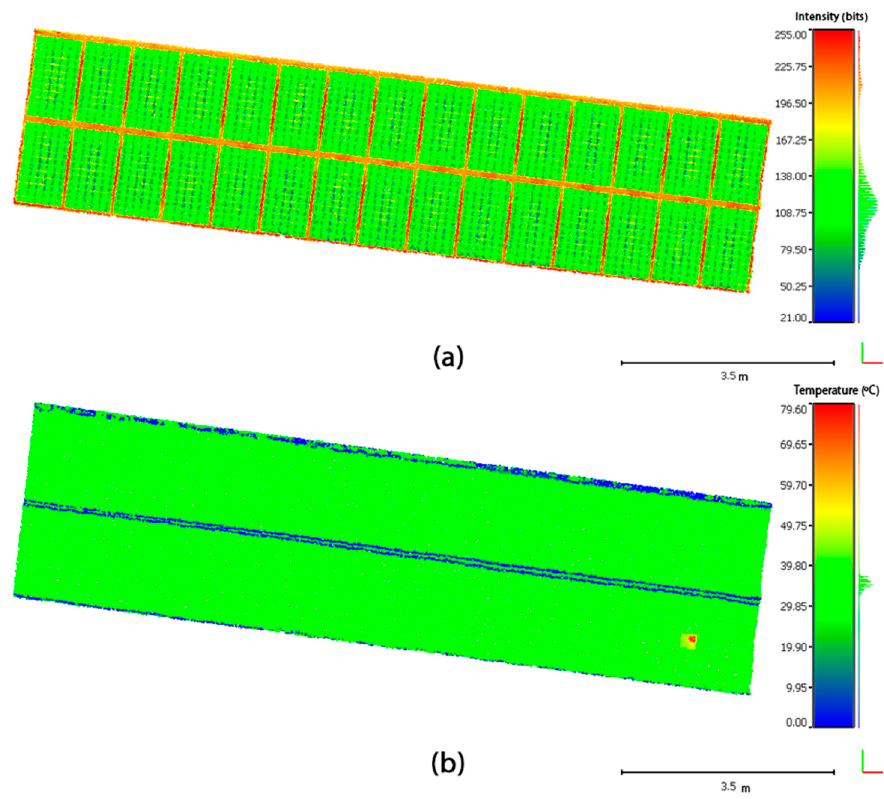
Figure 5. Multidimensional metric product: ( a ) hybrid 4D point cloud with intensity radiometry; and ( b ) hybrid 4D point cloud with thermographic radiometry.